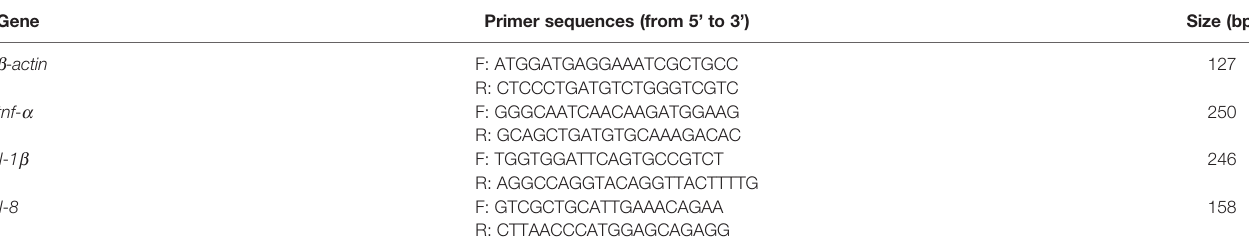
TABLE 1 | Sequences of primer pairs used in the real-time quantitative PCR